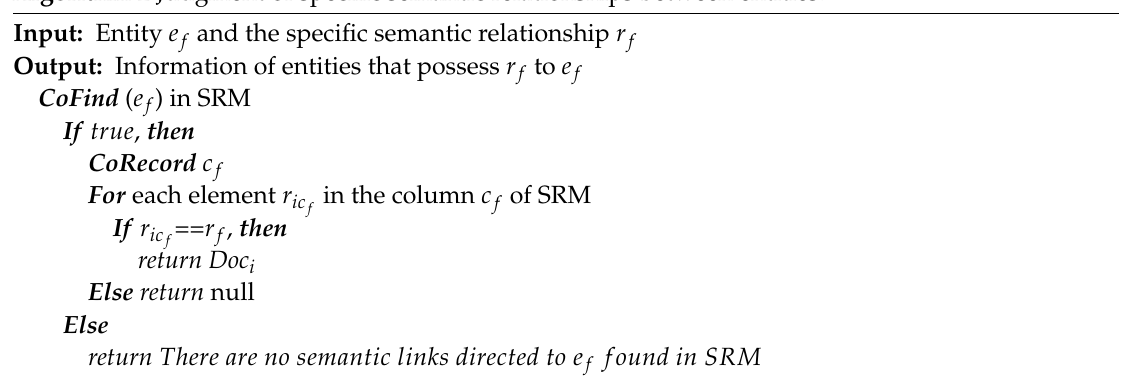
Algorithm 2 Judgment of specific semantic relationships between